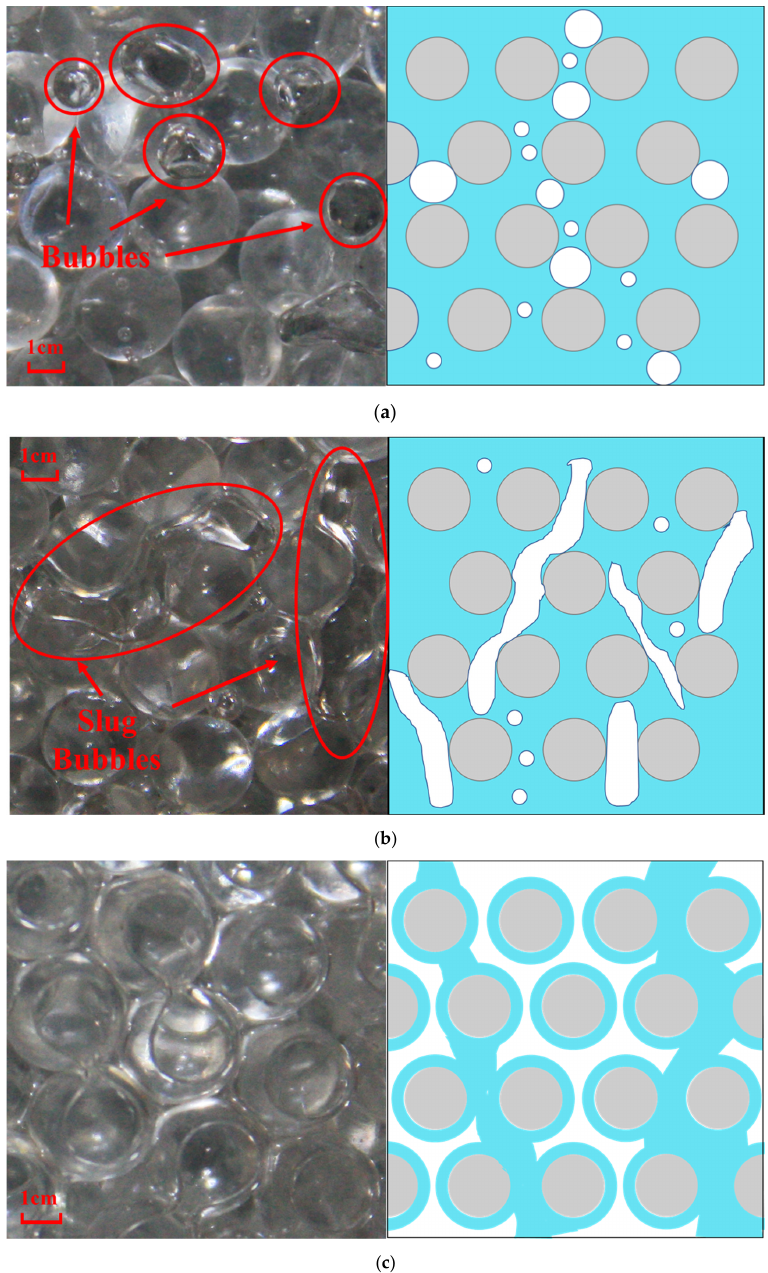
Figure 4. Photos and diagrams of typical flow patterns. ( a ). Photo and diagram of bubbly flow. ( b ). Photo and diagram of slug flow. ( c ). Photo and diagram of annular flow.